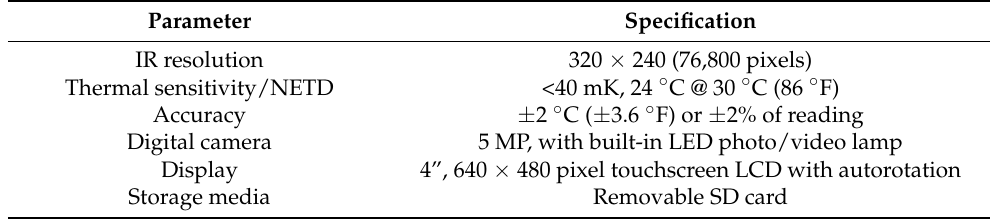
Table 2. Specification of the thermal camera [27].